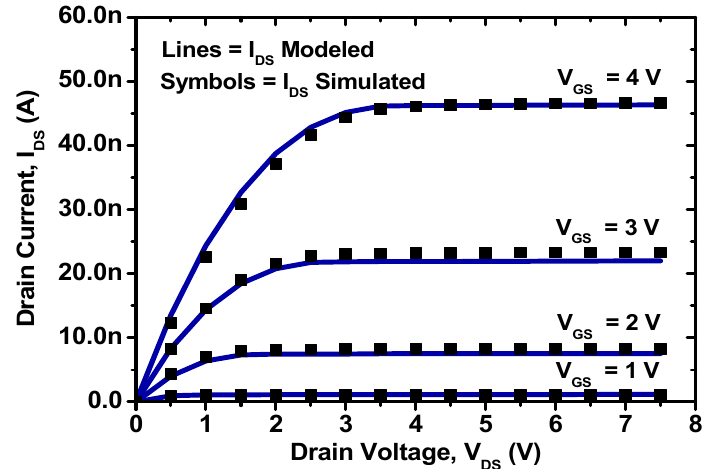
Figure 3. Comparison of modeled and simulated characteristic I DS vs V DS for various values of V GS = 1, 2, 3 and 4 Volts.